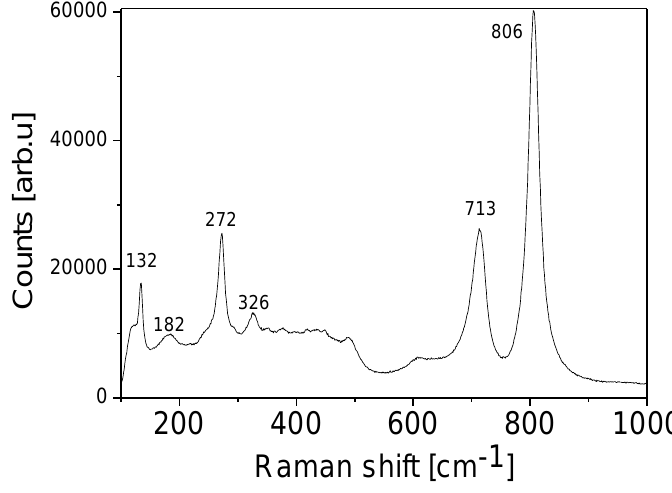
Figure 2. Raman spectra of the TO film annealed at 973 K.